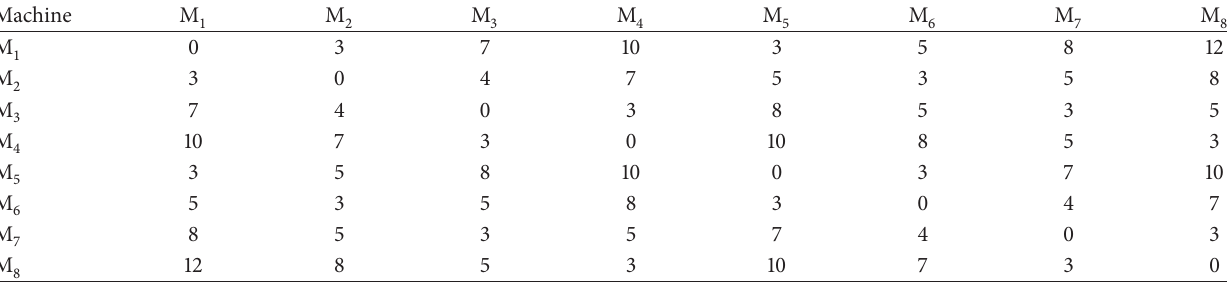
Table 2: Transportation time for 6 × 8 problem.